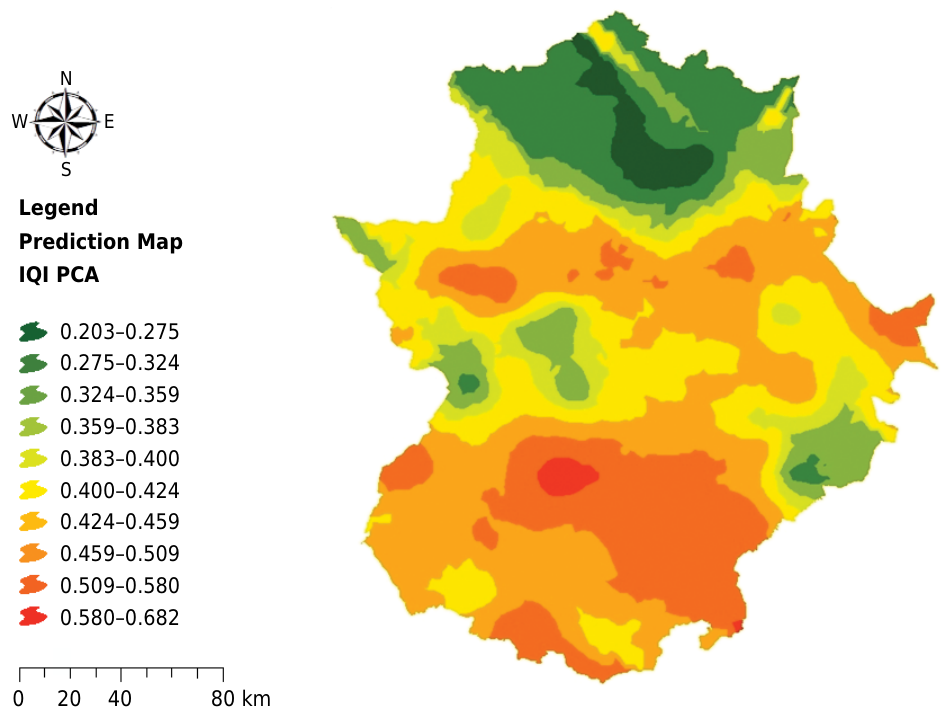
Figure 5. Spatial distribution map of IQI PCA using a kriging interpolation method.